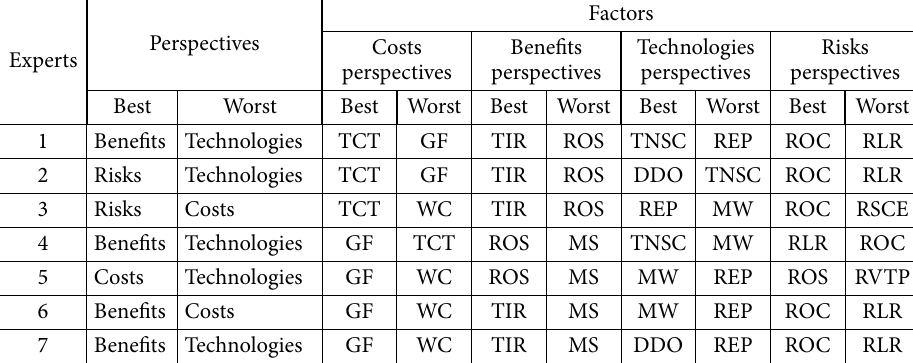
Table 6. The best and worst criteria in perspectives and factors